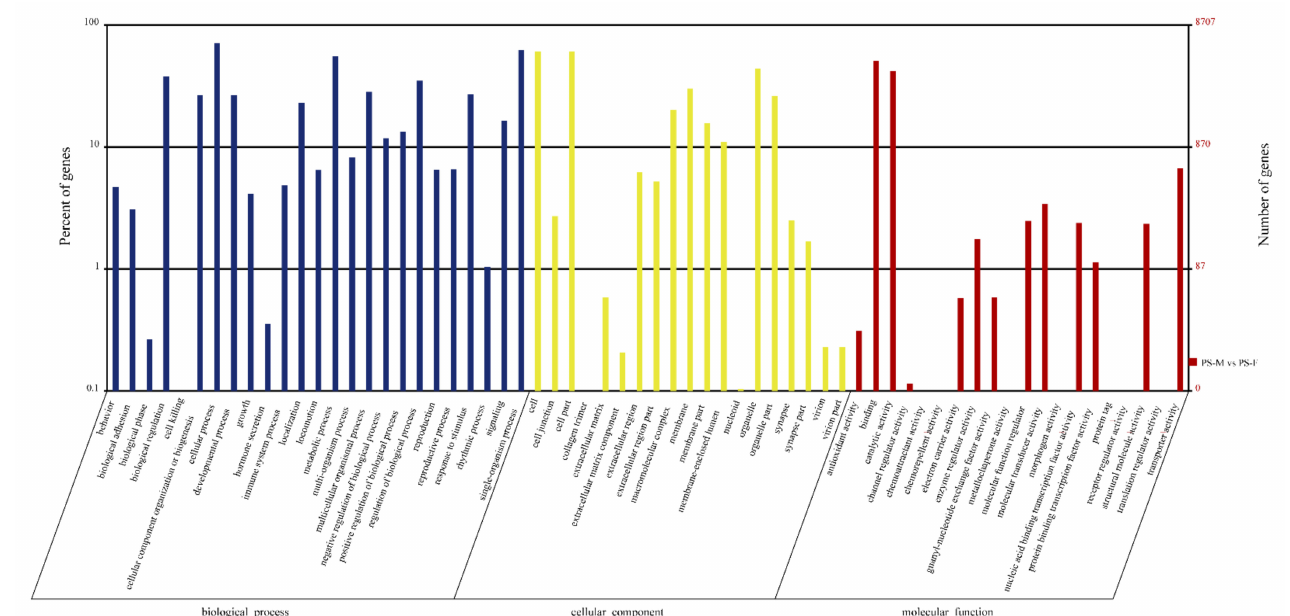
Figure 2. Gene ontology (GO) assignment of differentially expressed genes (DEGs) of Portunus sanguinolentus . GO functions is showed in X -axis. The Y -axis shows the percent and number of genes which have the GO